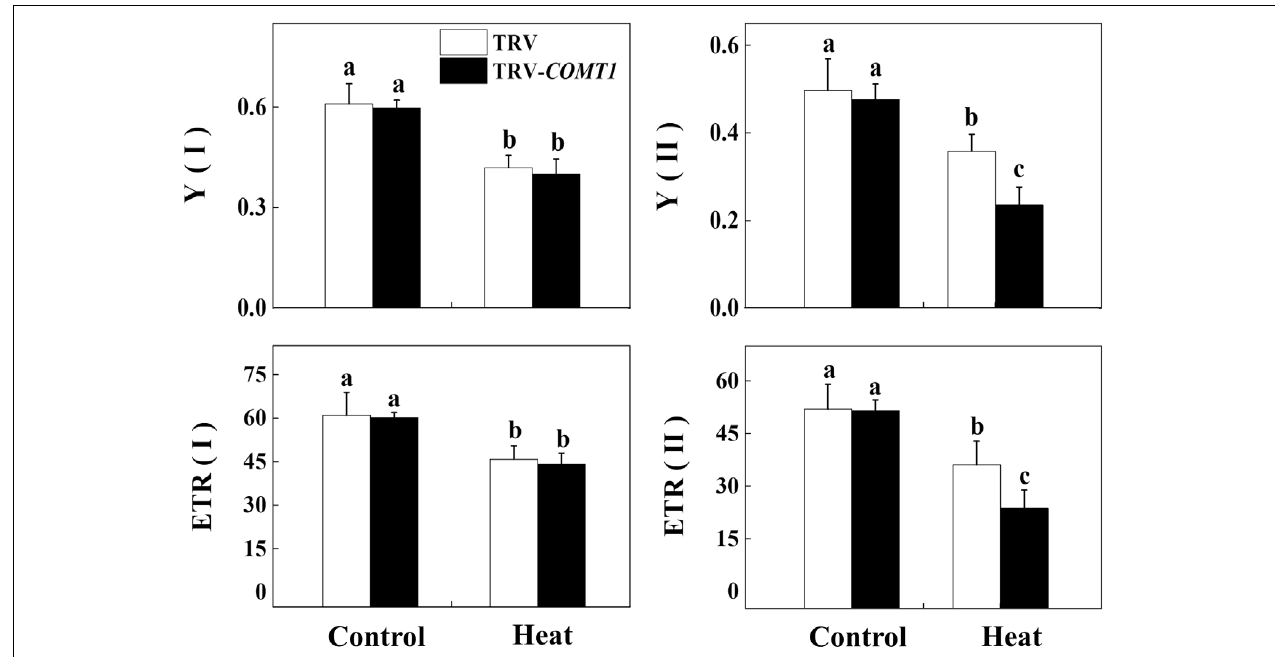
FIGURE 4 | Effect of COMT1 silencing and heat stress on quantum yield and electron transport rate in PSI and PSII in tomato leaves. Tomato seedlings at five-leaf stage were exposed to 40 ◦ C temperature for 9 h before analysis of chlorophyll fluorescence parameters. The bars (means ± SE, n = 6) labeled with different letters are significantly different at P < 0.05 according to Tukey’s test. Y(I), effective quantum yield of PSI; Y(II), effective quantum yield of PSII; ETR(II), electron transport rate of PSII; ETR(I), electron transport rate of